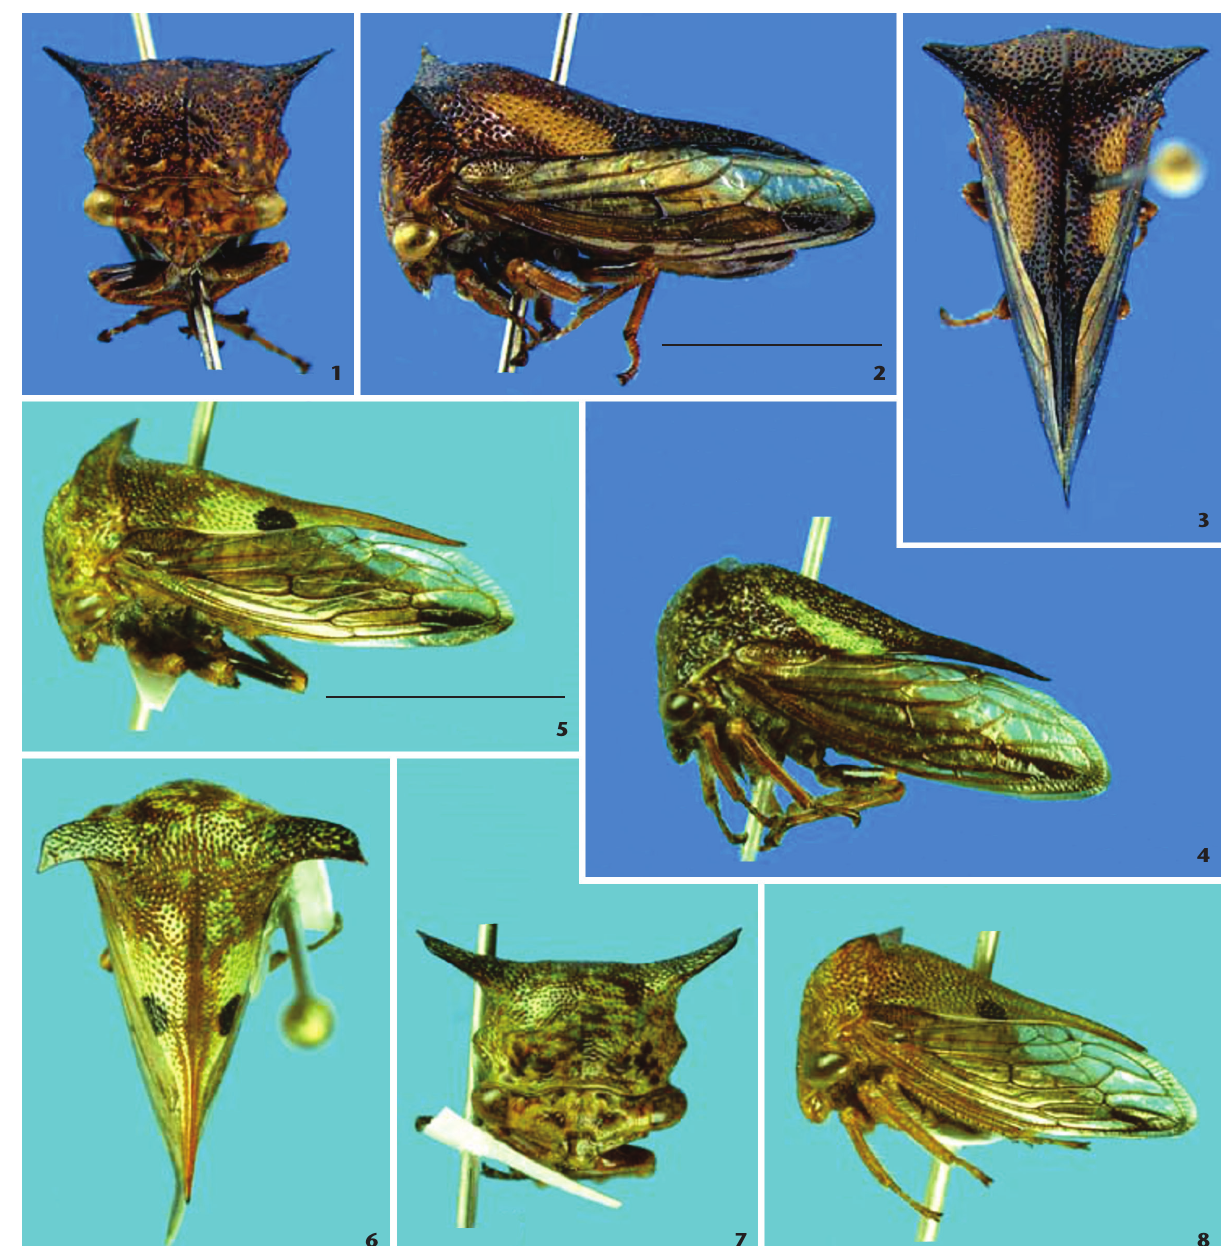
7Figures margin widely arched; eyes ovoid; ocelli closer to each other than to eyes, situated just bellow transocular line;